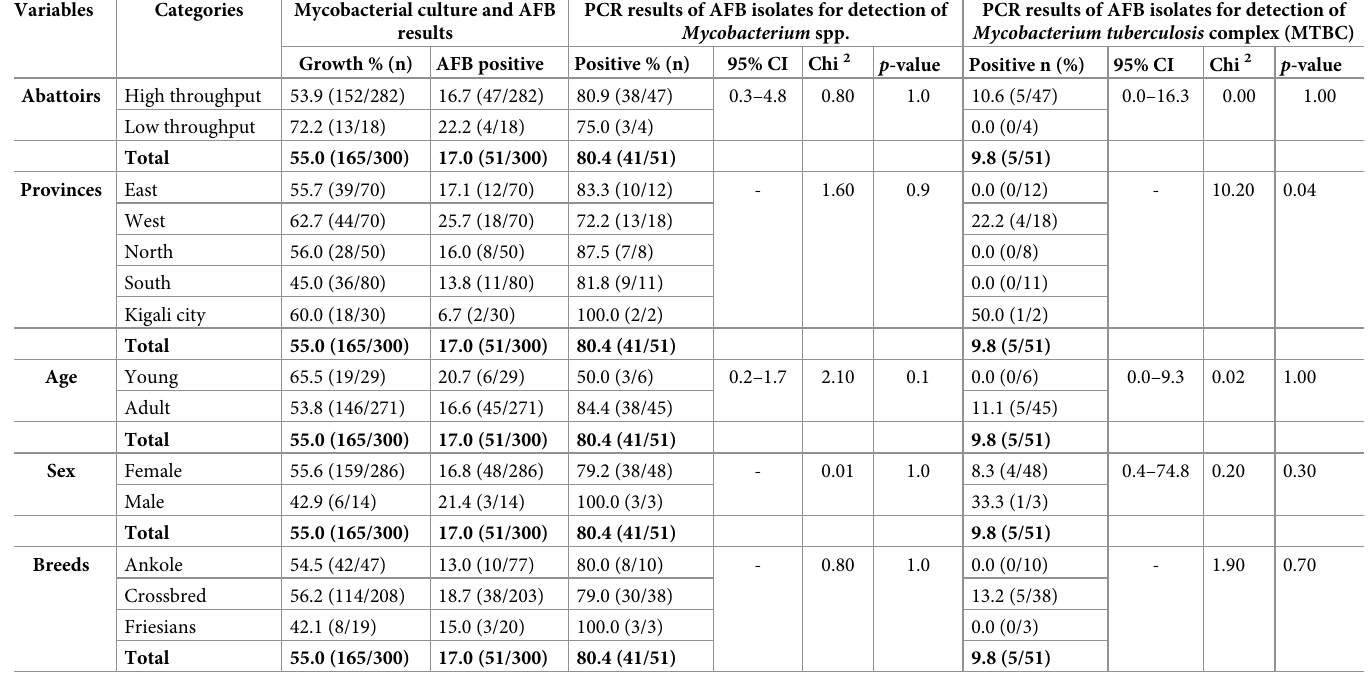
Table 2. Mycobacterial culture results for 300 slaughtered cattle and PCR results of acid-fast bacilli isolates stratified by the abattoir, age, breed, and sex of slaugh- tered cattle in